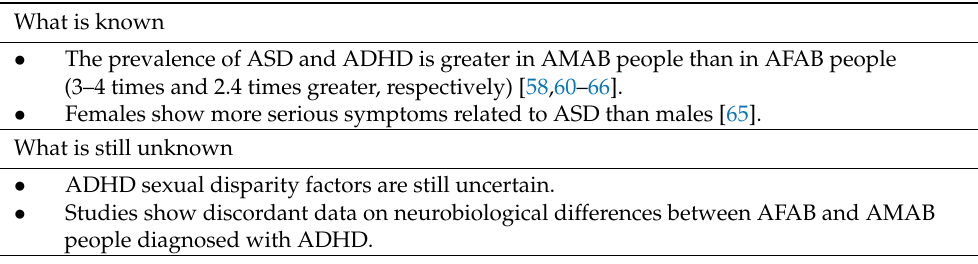
Table 3. Available evidence on the relationship between autism spectrum disorders (ASD), attention- deficit/hyperactivity disorder (ADHD) and